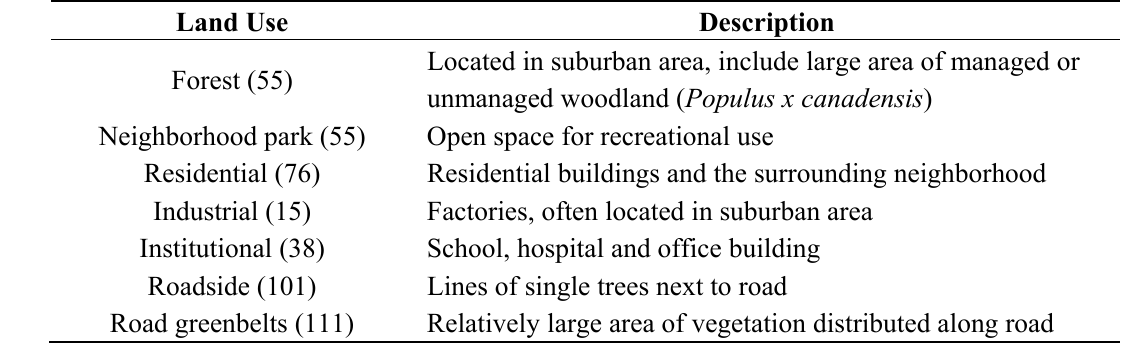
Table 2. Description of seven typical land use types in the urban